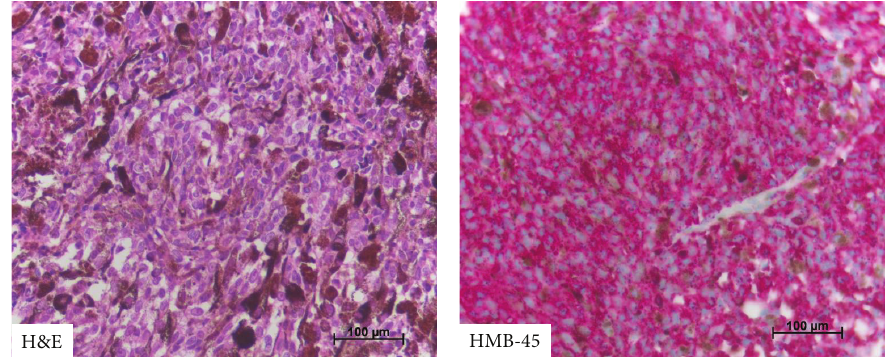
Figure 2: Illustration of the histology (H&E) and immunohistochemistry (HMB-45) of the investigated tumor. Tumor cells are polygonal with prominent nucleoli and partially pigmented (H&E). Tumor cells express the melanoma specific protein HMB-45. Tumor cells were also positive for MELAN-A and S-100 (not shown). Scale bars represent 100 𝜇 m; magnification × 400